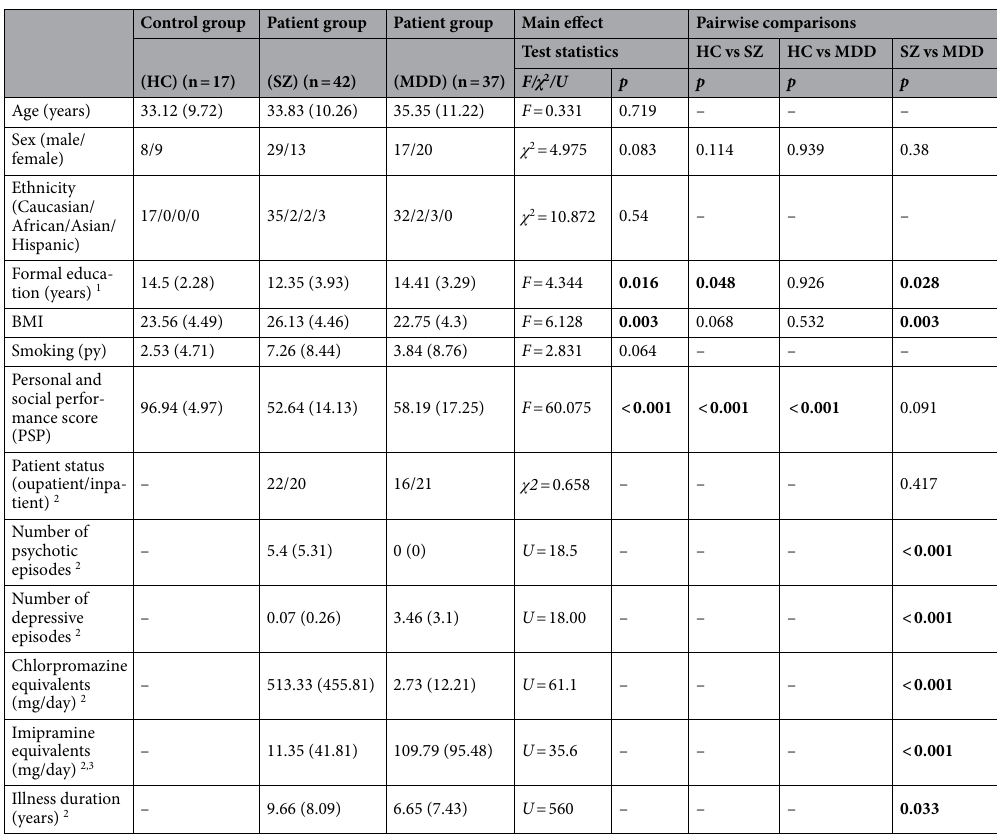
Table 1. Sociodemographic data. Data are presented as means and standard deviations. Potential group differences between all three groups were investigated using ANOVA. P values lower than 0.05 are in bold, correction for multiple testing applied using FDR for pairwise comparisons. For comparison between the two patient groups, Mann Whitney U was used. BMI body mass index, HC healthy control participants, Py pack years, MDD major depressive disorder, SZ Schizophrenia. 1 Compulsory education in Switzerland is 9 years. 2 Test statistics are only applicable to patient group. 3 Calculation based on equivalent doses according to 72 .